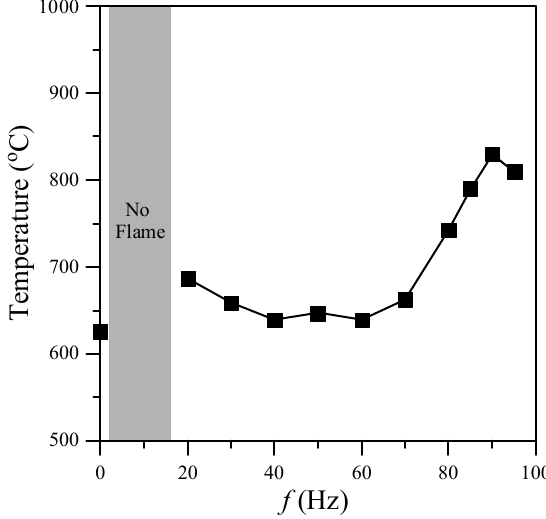
Figure 4. Gas temperature at z = 10 mm above burner exit for various excitation